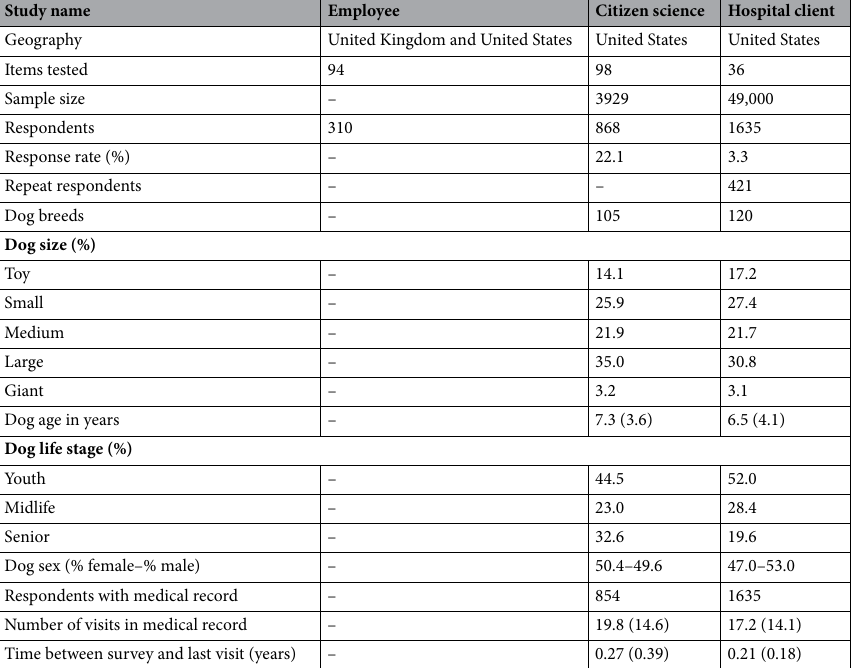
Table 1. Characteristics and basic signalment information for the 3 studies performed. Summaries for continuous variables are given as mean (standard